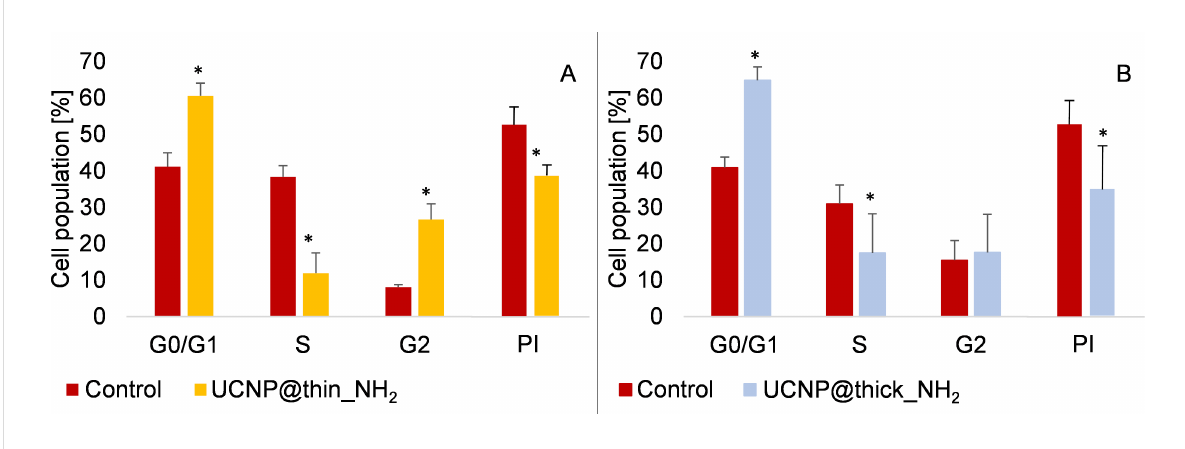
Figure 4: Effect of (A) UC@thin_NH 2 ( t SiO2 = 8 ± 2 nm) and (B) UC@thick_NH 2 ( t SiO2 = 21 ± 2 nm) on the cell cycle dynamics of RAW 264.7 macro- phages after 24 h of exposure. The concentration used was 200 µg/mL. The asterisk indicates significant differences relative to the control p <